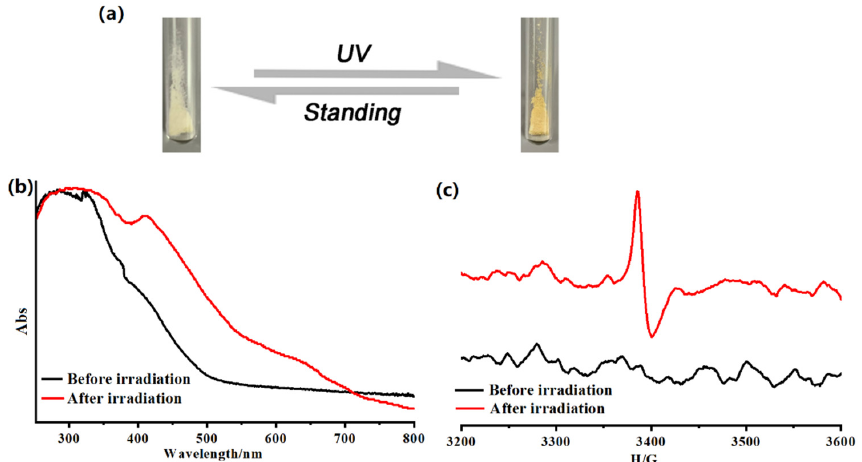
Figure 3. ( a ) Photographs, ( b ) Normalized UV − vis adsorption spectra and ( c ) EPR spectra of compound 1 before and after irradiation with a UV lamp.